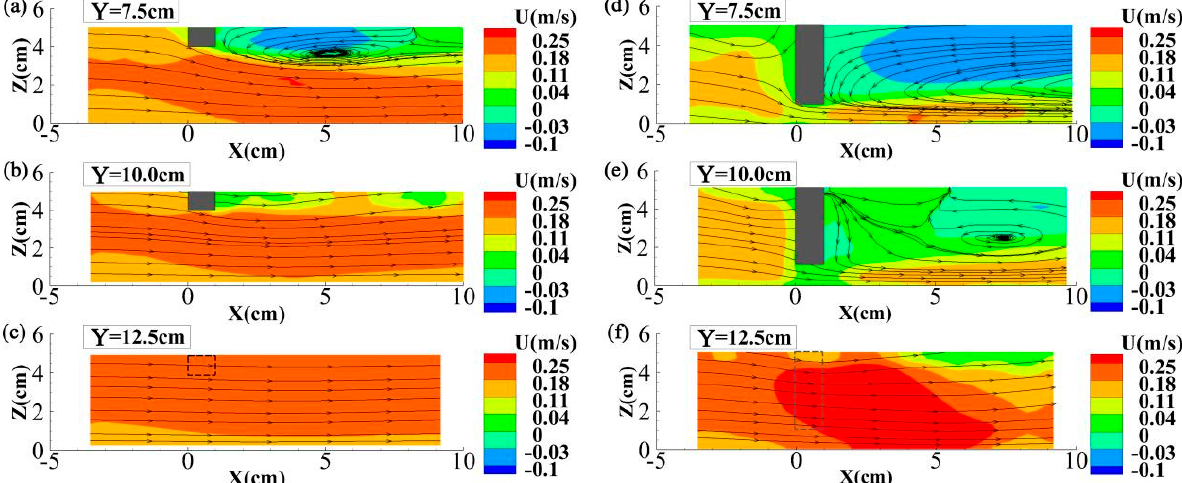
Figure 7. Distributions of vertical turbulent intensity (on the left) at longitudinal sections ( a ) Y = 7.5 cm, ( b ) Y = 10.0 cm, ( c ) Y = 12.5 cm, and the <u’w’> component of Reynolds stress (on the right) at longitudinal sections ( d ) Y = 7.5 cm, ( e ) Y = 10.0 cm, ( f ) Y = 12.5 cm in Case 2. The grey areas in subfigures ( a , b , d , e ) demonstrate the floating dike, and the dotted lines in subfigures ( c , f ) indicate the location of floating dike in the coordinate system.